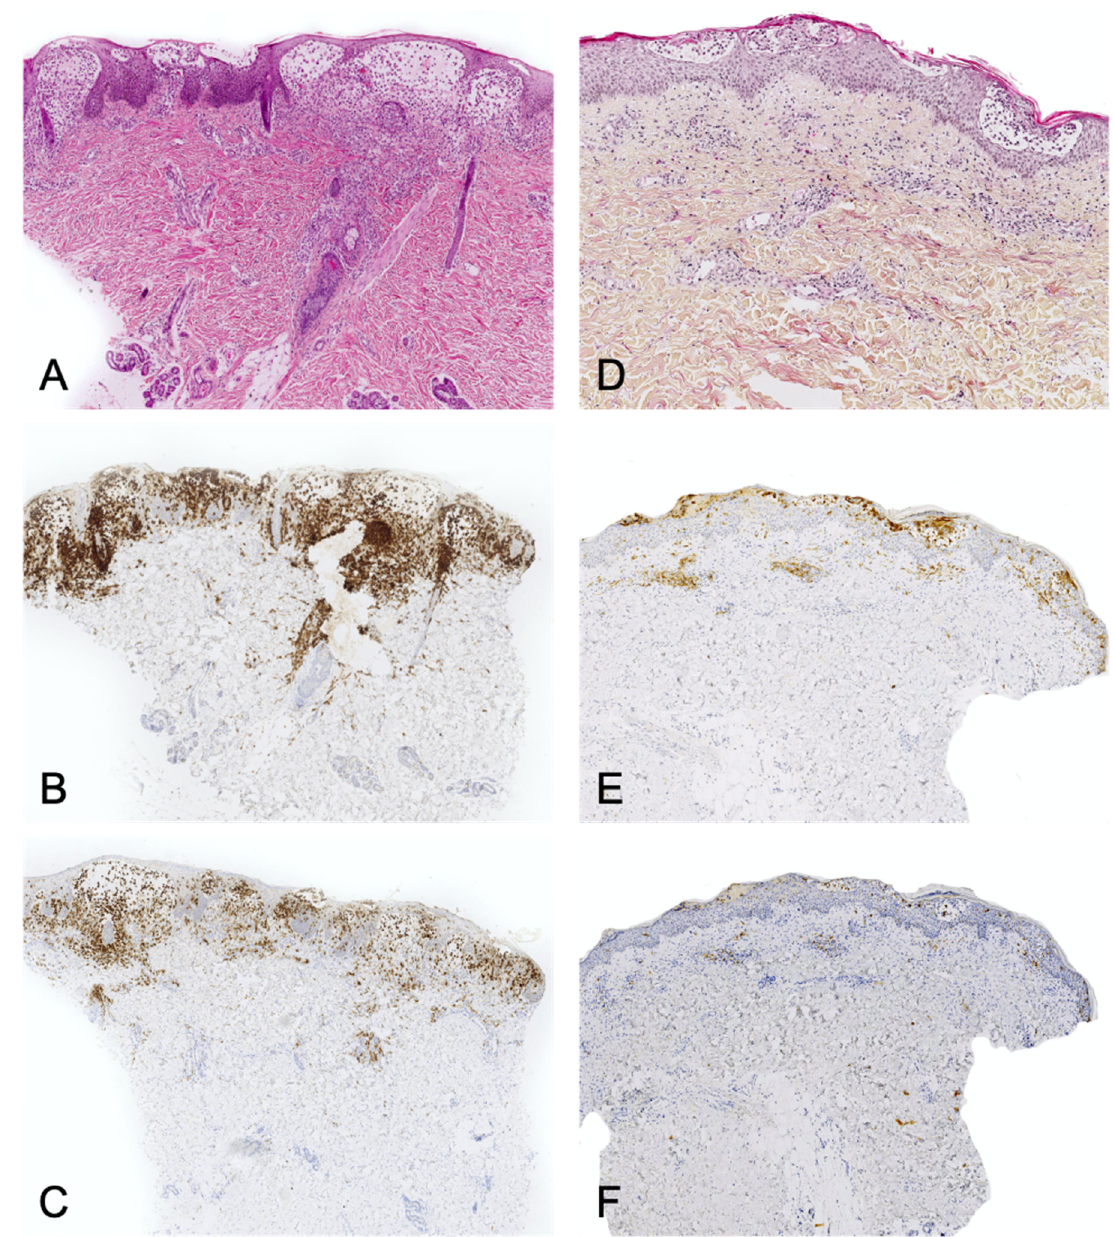
Figure 5. Left panel: Langerhans cell histiocytosis. ( A ): HE × 40. Superficial infiltrate of histiocytes with epidermotropism and edema. ( B ): CD1a immunostaining. ( C ): CD207/Langerin immunostaining. The whole infiltrate express CD207. Right panel: spongiotic dermatitis with CD1a+ dendritic cell hyperplasia. ( D ): HE ×40. ( E ): CD1a immunostaining. ( F ): CD207/Langerin immunostaining. The true Langerhans cells in the epidermal vesicles express CD207. The dermal infiltrate is almost completely negative.